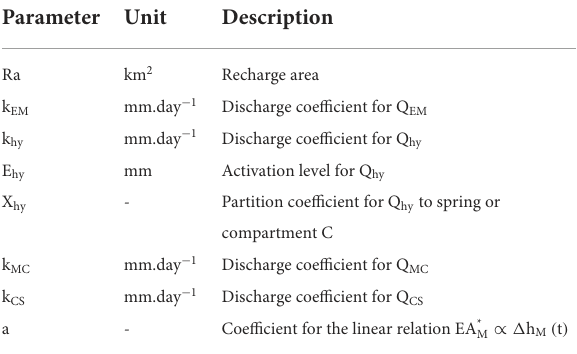
TABLE 1 Description of the model